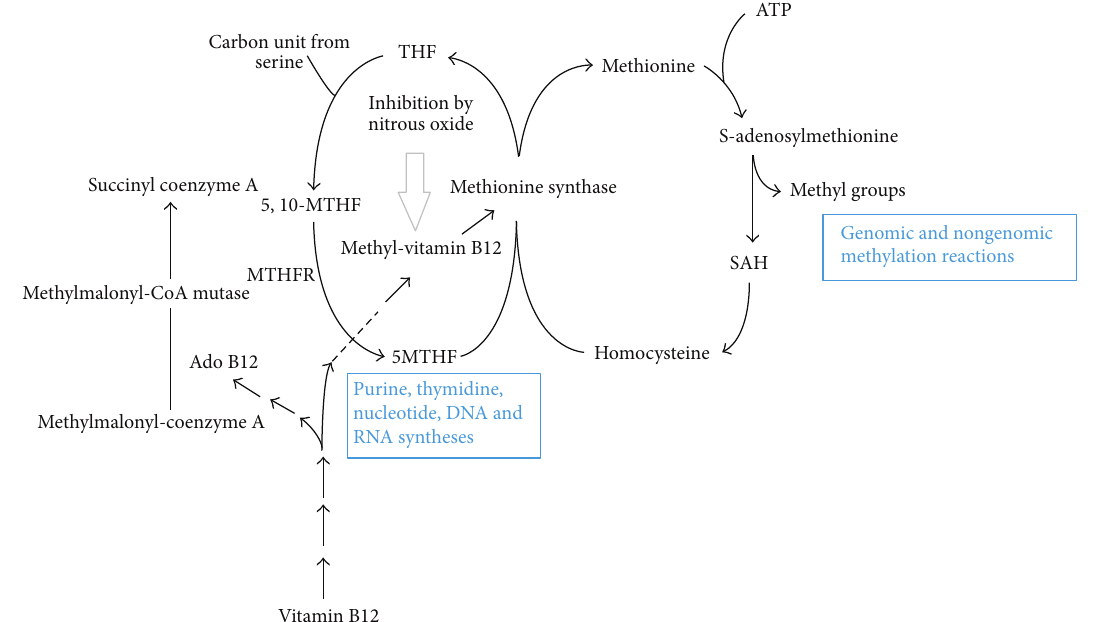
Figure 4: Pathways of intracellular vitamin B12 metabolism. MTHFR: methylenetetrahydrofolate reductase; 5,10-MTHF: 5,10-methylene- tetrahydrofolate; 5-MTHF: 5-methylenetetrahydrofolate; THF: tetrahydrofolate; SAH: S-adenosyl